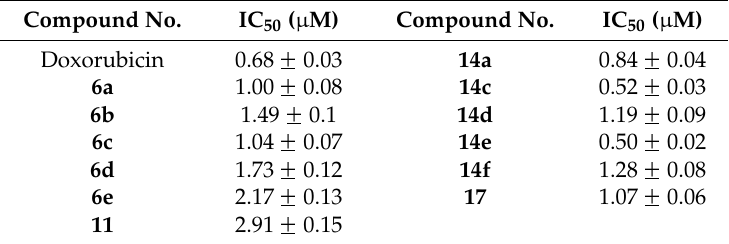
Table 1. IC 50 values of tested compounds ± standard deviation against HEP G2. Compound No. IC 50 ( μ M) Compound No. IC 50 ( µ